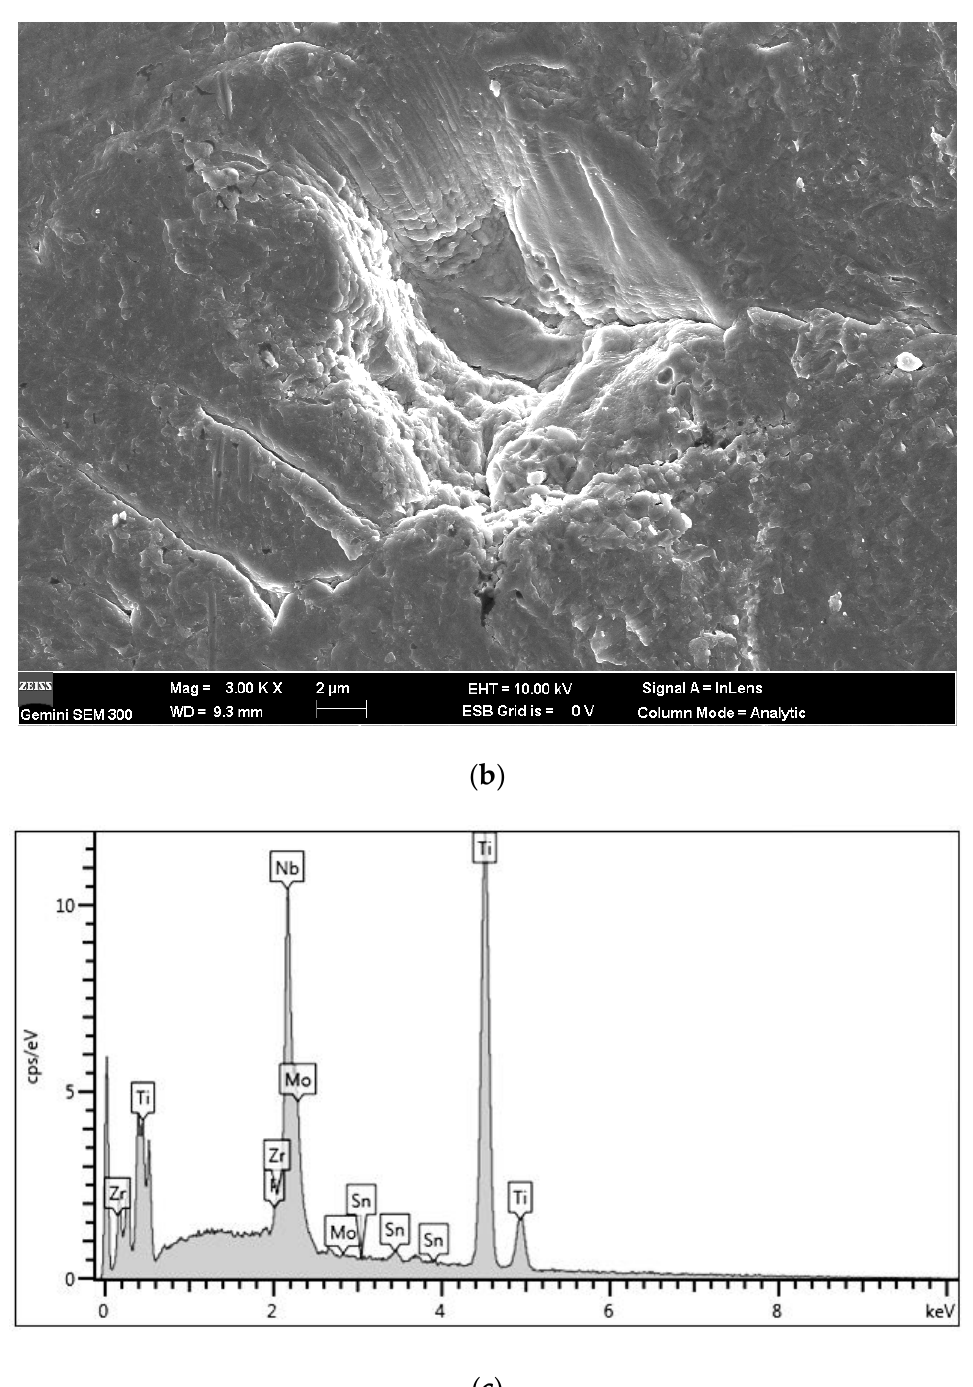
Figure 8. Cont Figure 8. Fracture surface of TLM (UI-24000, 500 MPa, 1.86 × 10 6 cycles): ( a ) Overall view of fracture surface; ( b ) slip trace of crystals in the crack initiation; ( c ) EDX analysis of crack core.